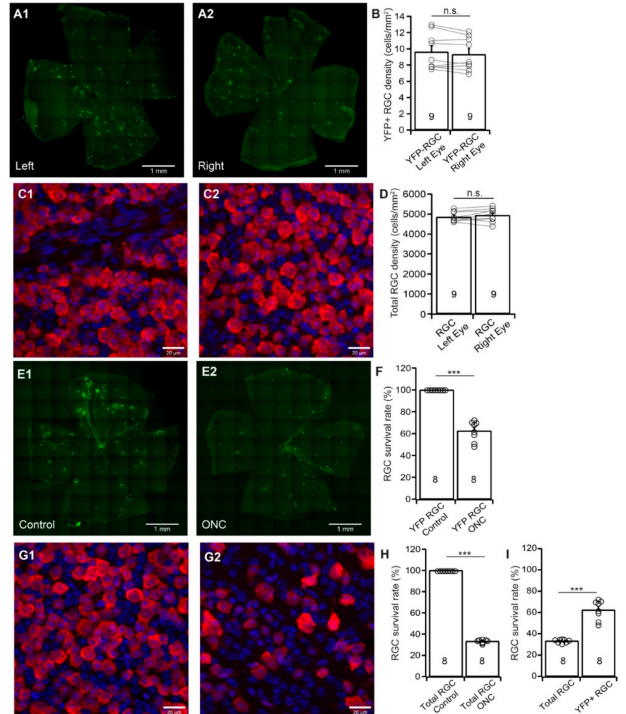
Figure 2. YFP-expressing RGCs of YFP-H mice are more resistant to ONC than total RGCs. We determined whether YFP-expressing RGCs of Thy1-YFP mice could serve as a model to predict overall RGC death in retinal diseases. ( A ) Representative images of flat-mount whole retinas of left ( A1 ) and right ( A2 ) eyes of a Thy1-YFP mouse. ( B ) Comparison of the densities (cells / mm 2 ) of the YFP-expressing RGCs of the left and right eyes of the same group of mice. The densities of YFP-expressing RGCs of left eyes were normalized to the right eyes, and the di ff erence in the densities of YFP-expressing RGCs between the left and right eyes is not statistically significant (paired t -test, p = 0.118). n.s.: not significant. ( C ) Representative magnified views of flat-mount retinas of left ( C1 ) and right ( C2 ) eyes of a Thy1-YFP mouse. The RGCs are labeled by an anti-RBPMS antibody (red) and the nuclei in the GCL are labeled by DAPI (blue). ( D ) Comparison of the anti-RBPMS-labeled RGC densities of the left and right eyes of the same group of mice shown in panel B. The densities of anti-RBPMS-labeled RGCs of the left eyes were normalized to the right eyes. The di ff erence between the densities of RGCs in left and right eyes is not statistically significant (paired t -test, p = 0.252). n.s.: not significant. E : Representative images of flat-mount whole retinas of a Thy1-YFP mouse without ONC (E1) and seven days after ONC (E2). ( F ) Comparison of the density of YFP-expressing RGCs of the left eyes seven days after ONC to the uncrushed right eyes of the same mice. The densities of YFP-expressing RGCs of eyes with ONC were normalized to the control eyes. The di ff erence between the control eyes and the eyes with ONC is statistically significant (paired t -test, p = 0.0003). *** p < 0.001. ( G ) Representative magnified views of anti-RBPMS-labeled (red) flat-mount retinas of a Thy1-YFP mouse without ONC (G1) and seven days after ONC (G2). The nuclei in the GCL are labeled by DAPI (blue). ( H ) Comparison of survival rates of anti-RBPMS-labeled RGCs of the eyes seven days after ONC to the control eyes of the same mice. The densities of anti-RBPMS-labeled RGCs of the eyes with ONC were normalized to the control eyes. The di ff erence between the control eyes and the eyes with ONC is statistically significant (paired t -test, p < 0.0001). *** p < 0.001. ( I ) Comparison of the survival rates of anti-RBPMS-labeled RGCs and YFP-expressing RGCs from the same eyes seven days after ONC. The densities of anti-RBPMS-labeled and YFP-expressing RGCs of the eyes with ONC were normalized to their uncrushed control eyes of each mouse. The survival rate of YFP-expressing RGCs is significantly higher than that of anti-RBPMS-labeled RGCs from the same eyes (paired t -test, p < 0.0001). *** p < 0.001. The number of n in each column of panels B, D, F, H, and I indicates the number of eyes for each group, and the circles are individual